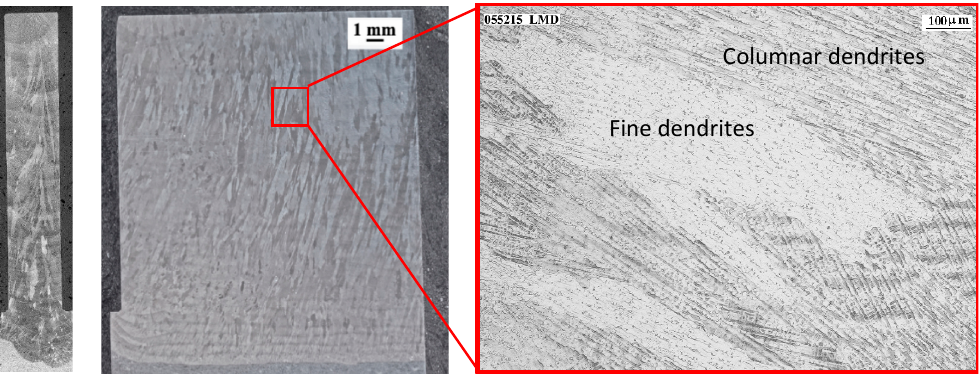
Figure 6. Macrographs and microstructure of the wall manufactured by LMD.